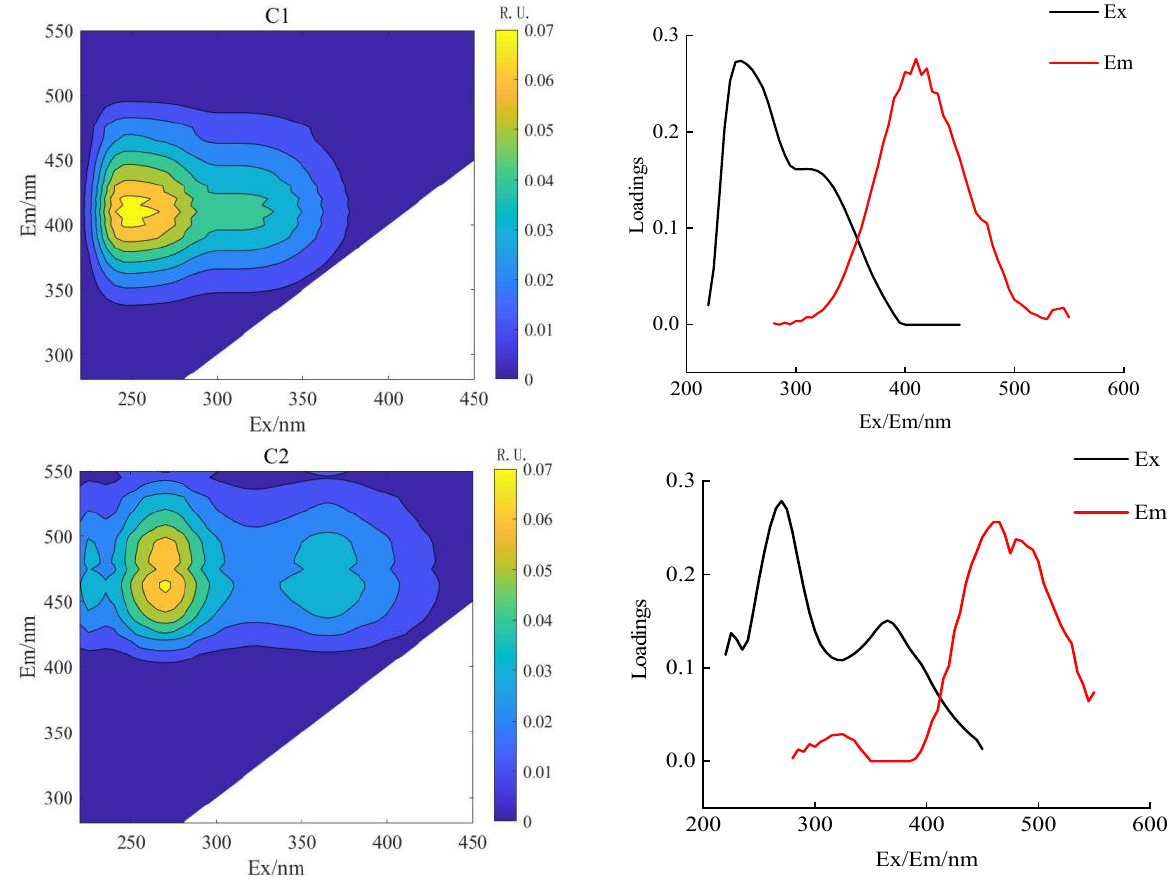
Figure 4. Parallel factor analysis of soil DOM in conventional subsurface drip irrigation.